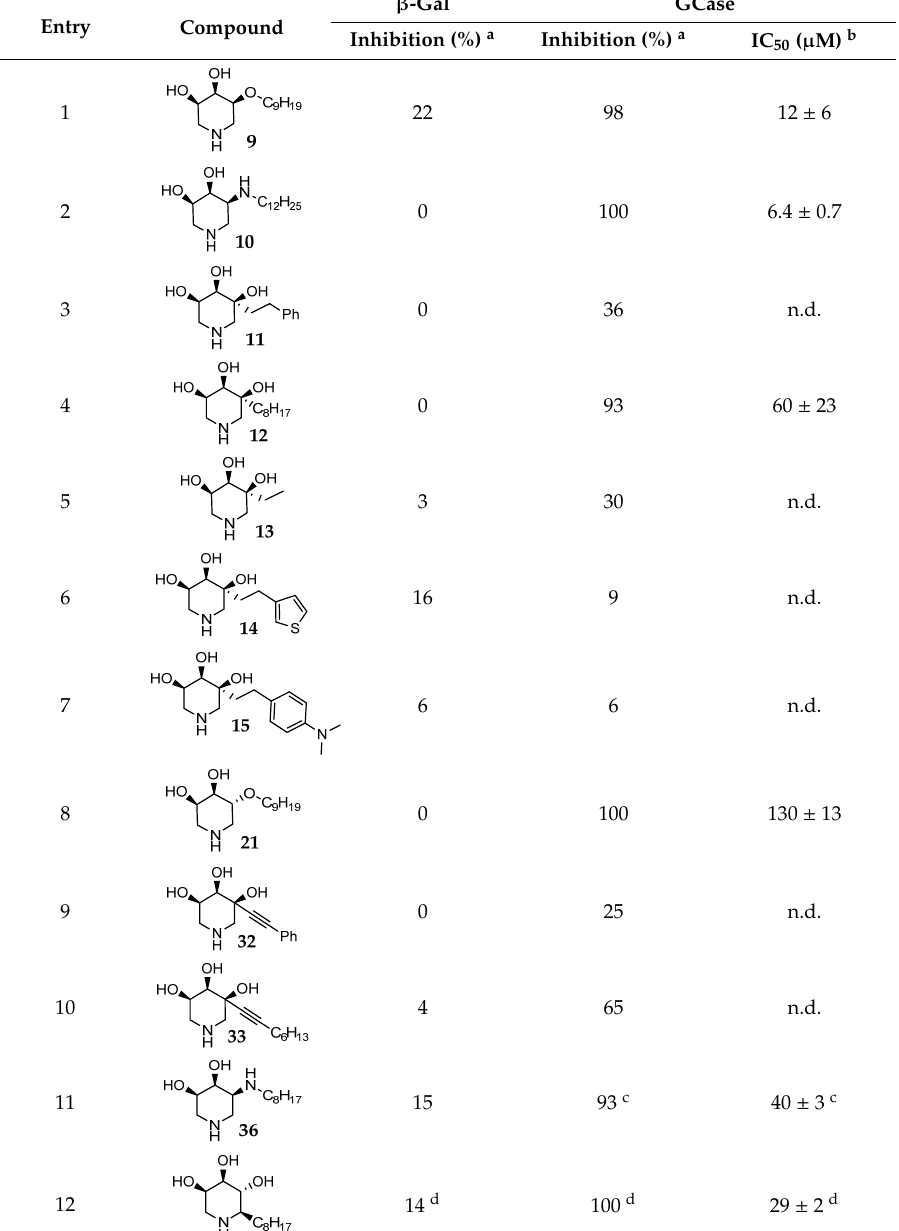
Table 4. β -galactosidase ( β -Gal) and β -glucosidase (GCase) inhibition in human leukocytes from healthy donors.